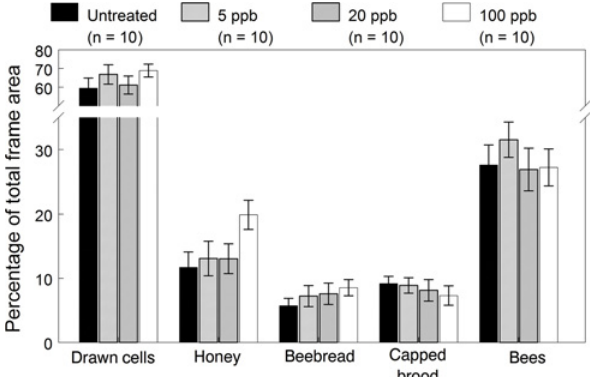
Fig 1. Colony performance endpoints of the 2009 colonies exposed for 12 weeks to untreated or imidacloprid-spiked diet patties. Means ( ± SE) are given for each endpoint recorded at the end of exposure (August